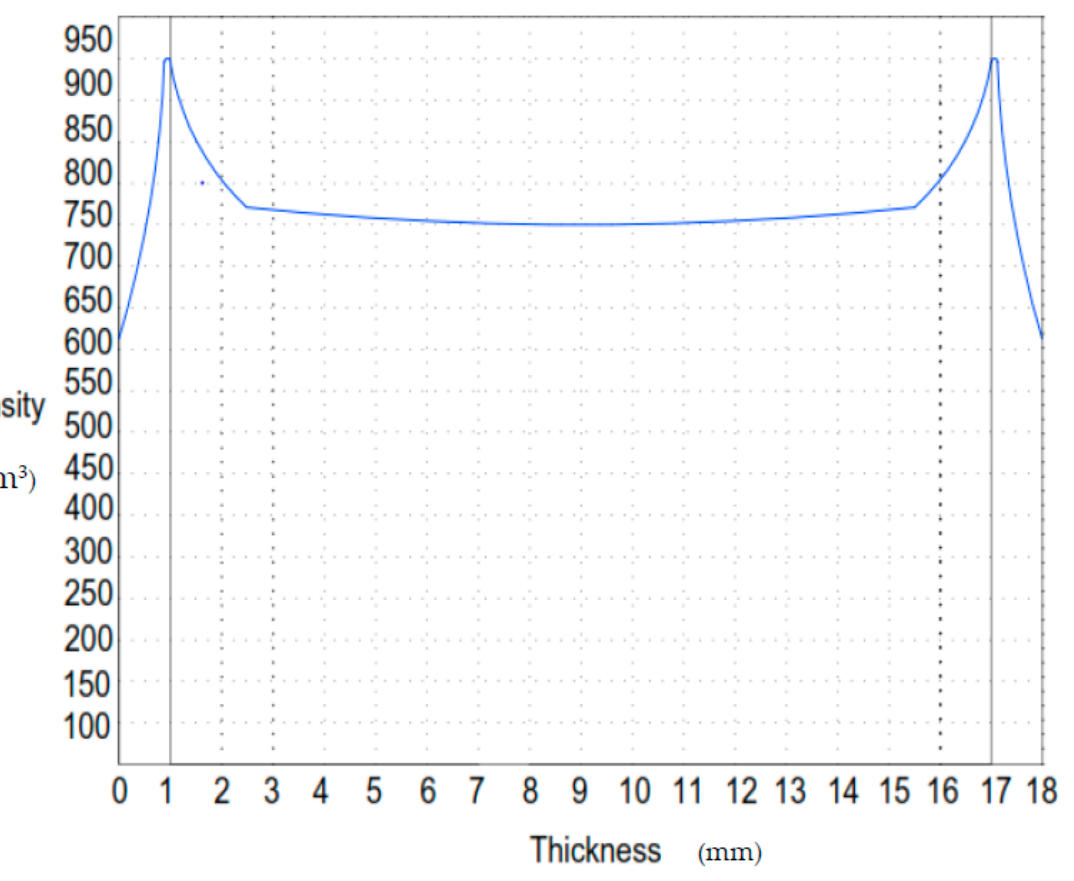
Figure 12. X-ray vertical density profile of 5thspecimen. Table 21. Bending tests. Table 23. Experimental data of 5 th sample.